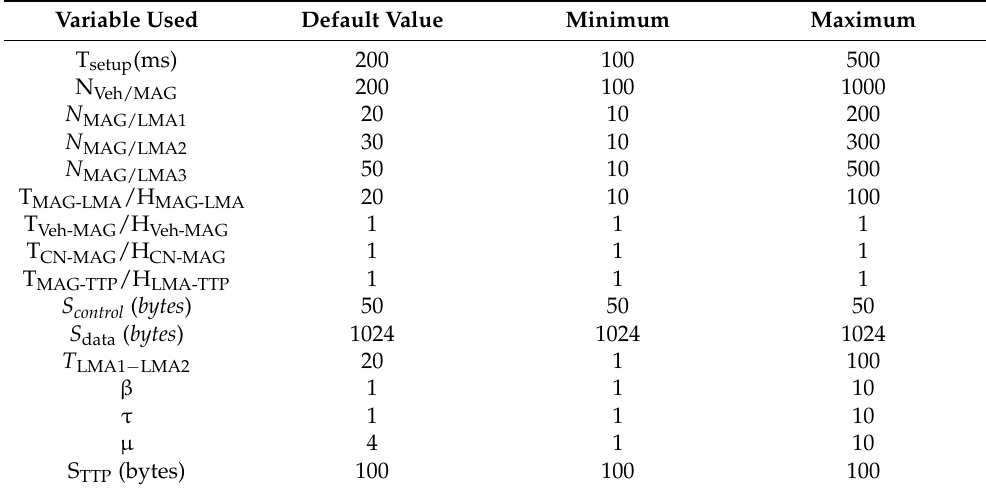
Table 2. Parameter values utilized in analyzing the handover cost of vehicle for VANET using PMIPV6. Variable